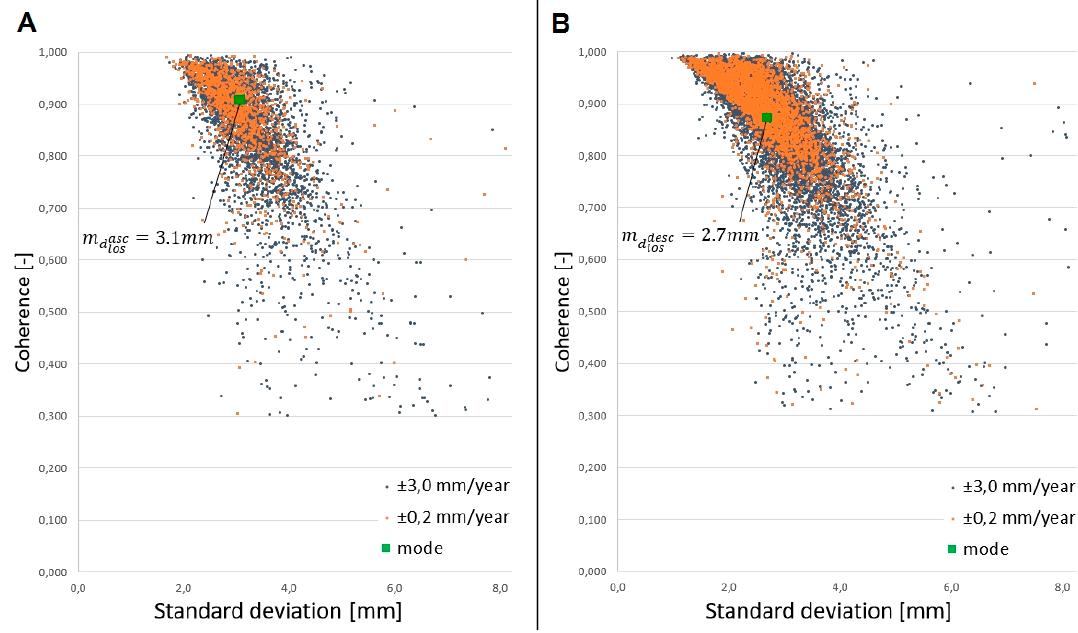
Figure 4. Relationship between coherence and the standard deviation between the observations and the linear model of vertical movement for Track 73 ( A ) and Track 22 ( B ).